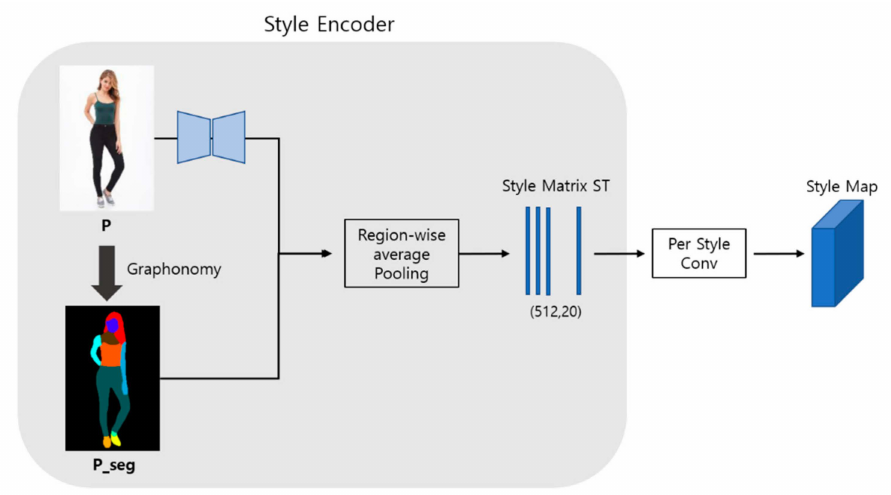
Figure 4. Style code generation